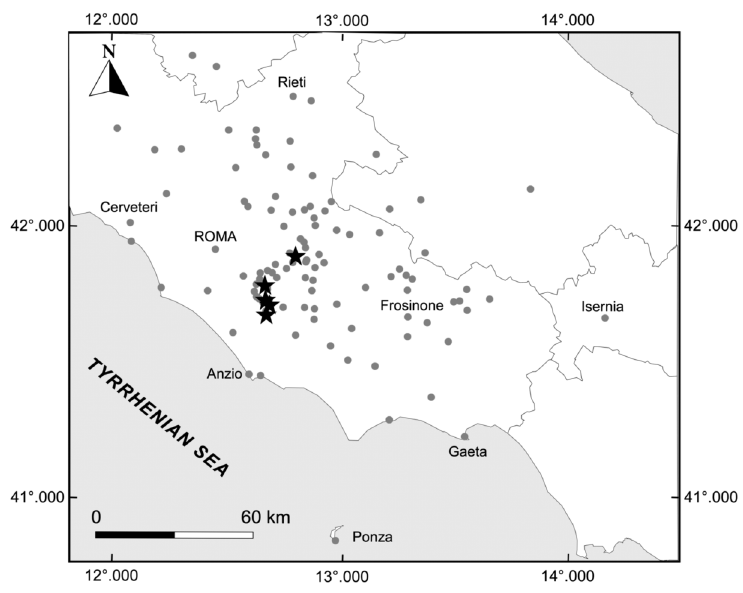
Fig. 6. Distribution of the epicentres and related 190 intensity site observations of the 5 earthquakes analysed for the Albani Hills (listed in table IV). Symbols as in fig. 2.